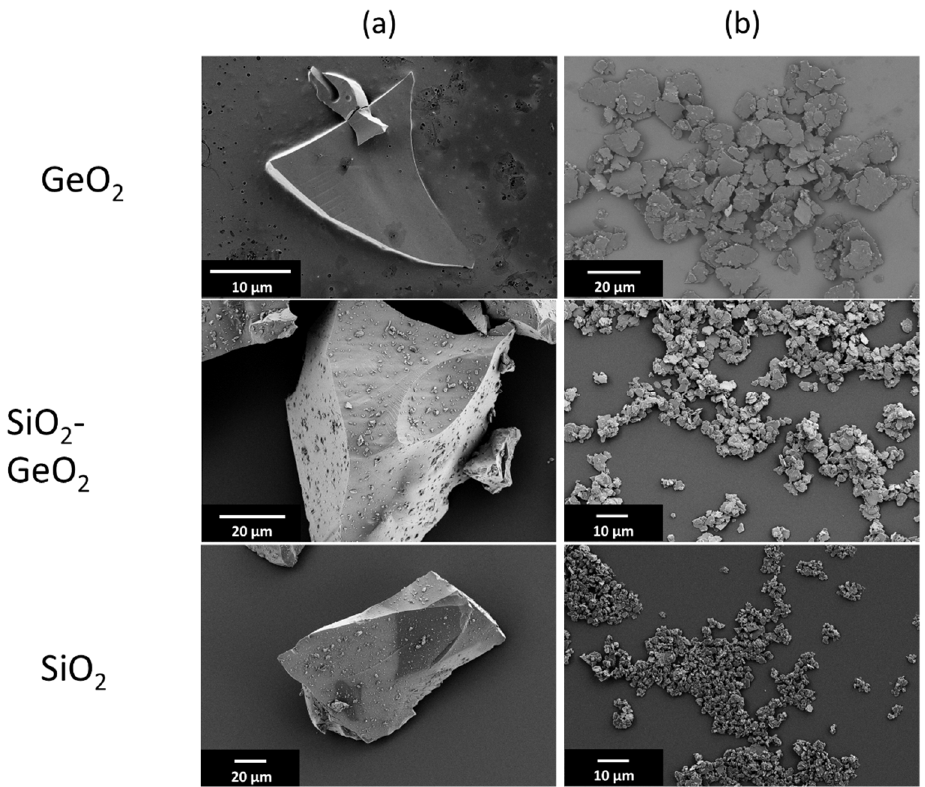
Figure 2. Glass after pre ‐ crushing ( a ) before the comminution step and comminuted glass flakes ( b ).